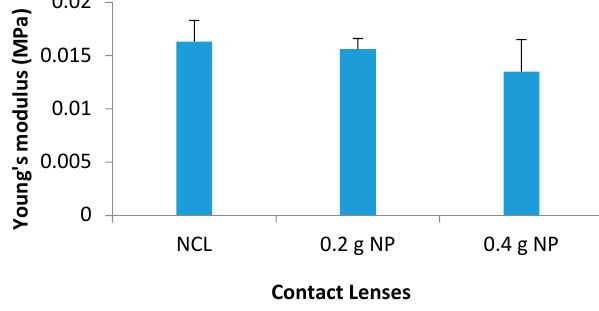
Figure 10. Young’s modulus (MPa) for all contact lenses.